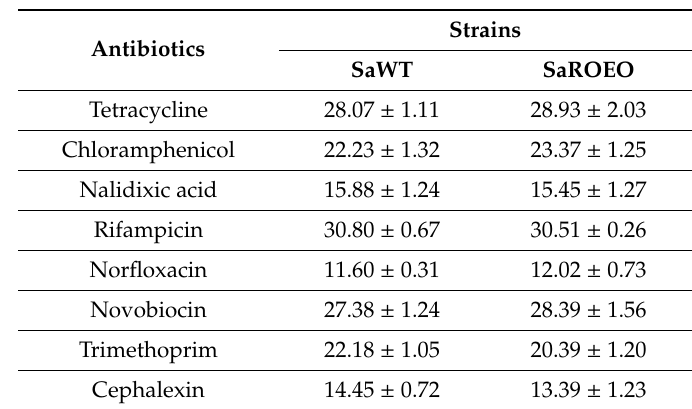
Table 3. Zones of growth inhibition (mm) for agar disk di ff usion assays of Staphylococcus aureus USA300 (SaWT) and evolved strains (SaROEO) against antibiotics: 30 µ g tetracycline, 30 µ g chloramphenicol, 10 µ g trimethoprim and 150 µ g cephalexin. Each value represents the mean diameter of the inhibition halo ± standard deviation from three independent